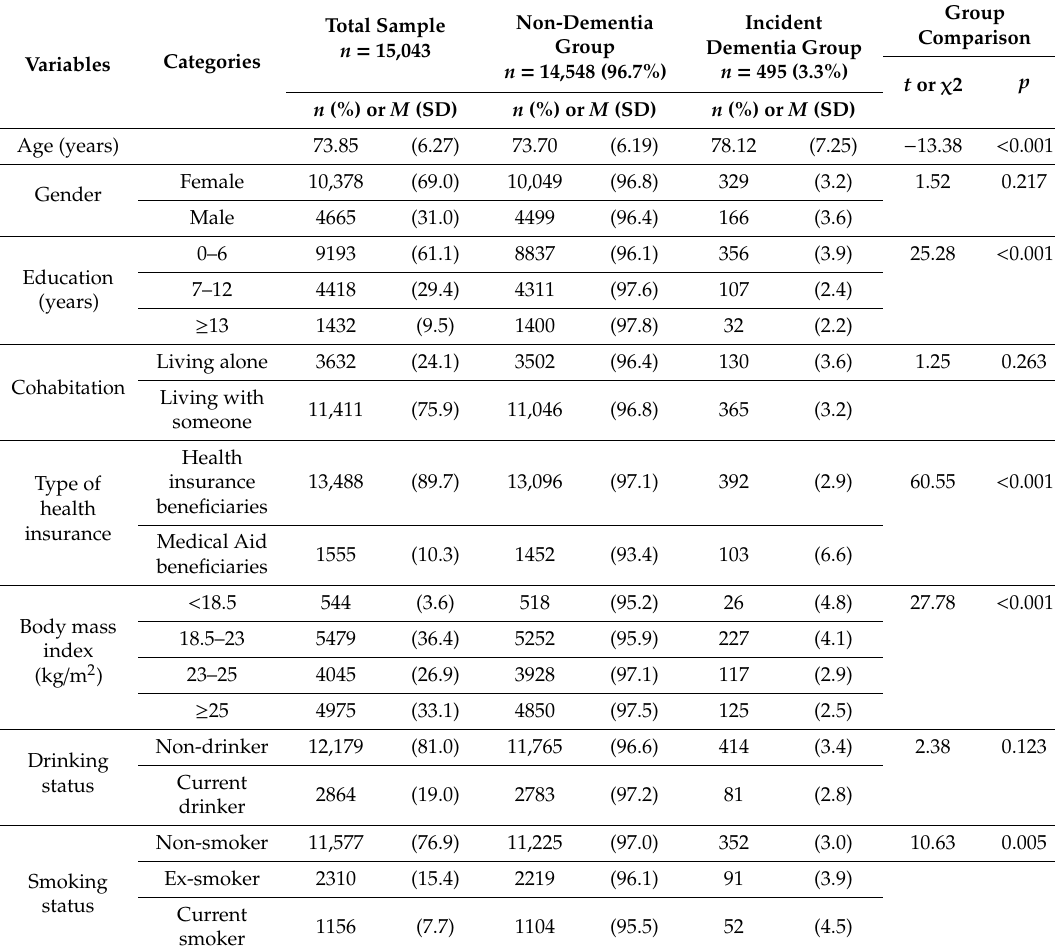
Table 1. Sociodemographic characteristics of the participants according to dementia incidence ( n =